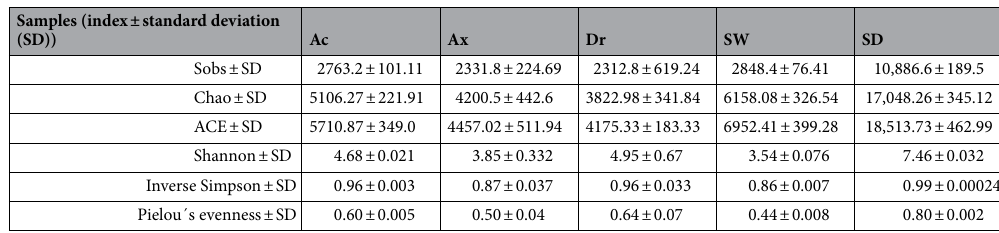
Samples (index ± standard deviation